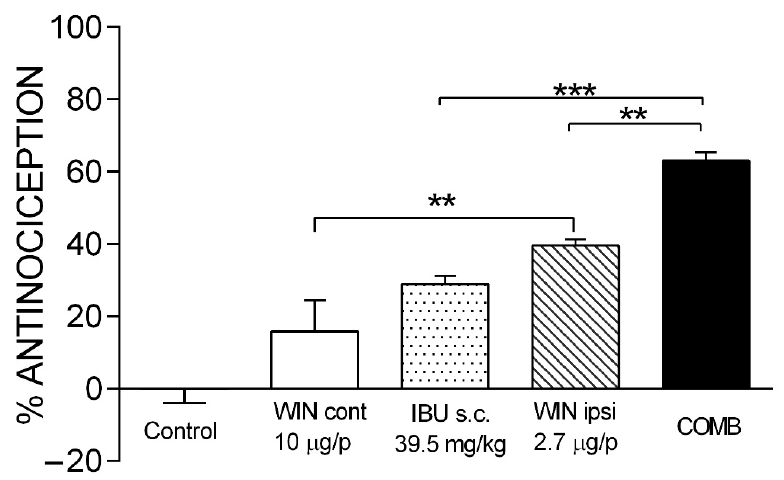
Figure 2. The antinociceptive effect of maximal efficacy COMB. The individual effects of IBU and WIN are shown as well as those of COMB. WIN was administered on both the ipsilateral paw (WIN ipsi) and contralateral paw (WIN cont) in the formalin model. There was no statistically significant difference between WIN cont and the control. Groups showing significant differences after one-way ANOVA were WIN ipsi compared with WIN cont (** p < 0.01), COMB compared with IBU (*** p < 0.001), and COMB compared with WIN ipsi (** p < 0.01). Each bar corresponds to the mean of six repetitions ± SEM.